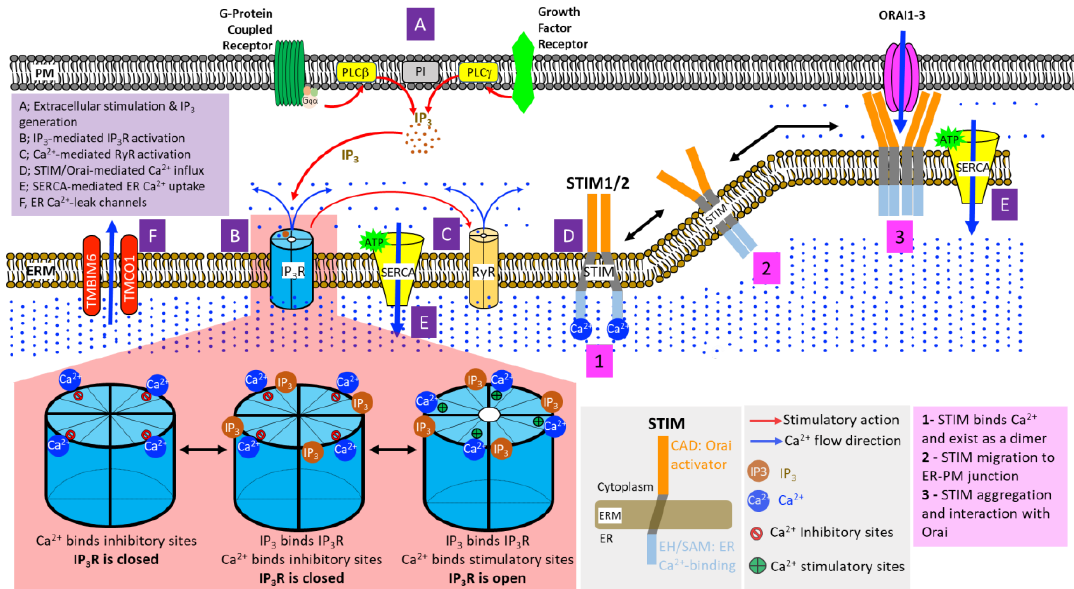
Figure 2. Mechanisms of ER Ca 2+ handling. ( A ) Stimulations of G-protein Coupled Receptors (GPCRs) and Receptor Tyrosine Kinases (RTKs) signal to phospholipase C-beta (PLC-beta) and PLC-gamma at the plasma membrane, respectively. This leads to PLC-mediated hydrolytic cleavage of phosphatidylinositol 4,5-bisphosphate, producing the Ca 2+ -mobilizing inositol-1,4,5-trisphosphate (IP 3 ) and diacylglycerol (DAG) (not shown in the figure) at the cell membrane. ( B ) Four molecules of IP 3 bind to the tetrameric IP 3 receptors (IP 3 Rs) on the ER membrane, exposing their stimulatory Ca 2+ binding sites while simultaneously obstructing inhibitory Ca 2+ binding sites. Upon the co-binding of Ca 2+ and IP 3 , IP 3 R channel pore opens, initiating ER Ca 2+ release. ( C ) Elevated cytosolic Ca 2+ further induces the opening of ryanodine receptors (RyRs) on the ER membrane, causing rapid and massive influx of ER Ca 2+ into the cytosol. ( D ) Dwindling luminal ER Ca 2+ results in the oligomerization of EF-SAM domain of stromal interaction molecules (STIMs), which, in turn, induces the multimerization of cytoplasmic STIM domains followed by translocation and assembly of STIM clusters at the ER-plasma membrane (ER-PM) junctions. In direct physical association with Orai channels on the plasma membrane, STIM clusters induce the opening of Orai channel pore, allowing extracellular Ca 2+ entry into the cytosol. ( E ) Powered by ATP hydrolysis, the Sarco/Endoplasmic Reticulum Ca 2+ -ATPases (SERCAs) shuttle the influx of extracellular Ca 2+ into the ER or SR, restoring cellular Ca 2+ homeostasis. ( F ) ER Ca 2+ -leak channels, such as TMBIM6 and TMCO1, prevent ER Ca 2+ over-filling.